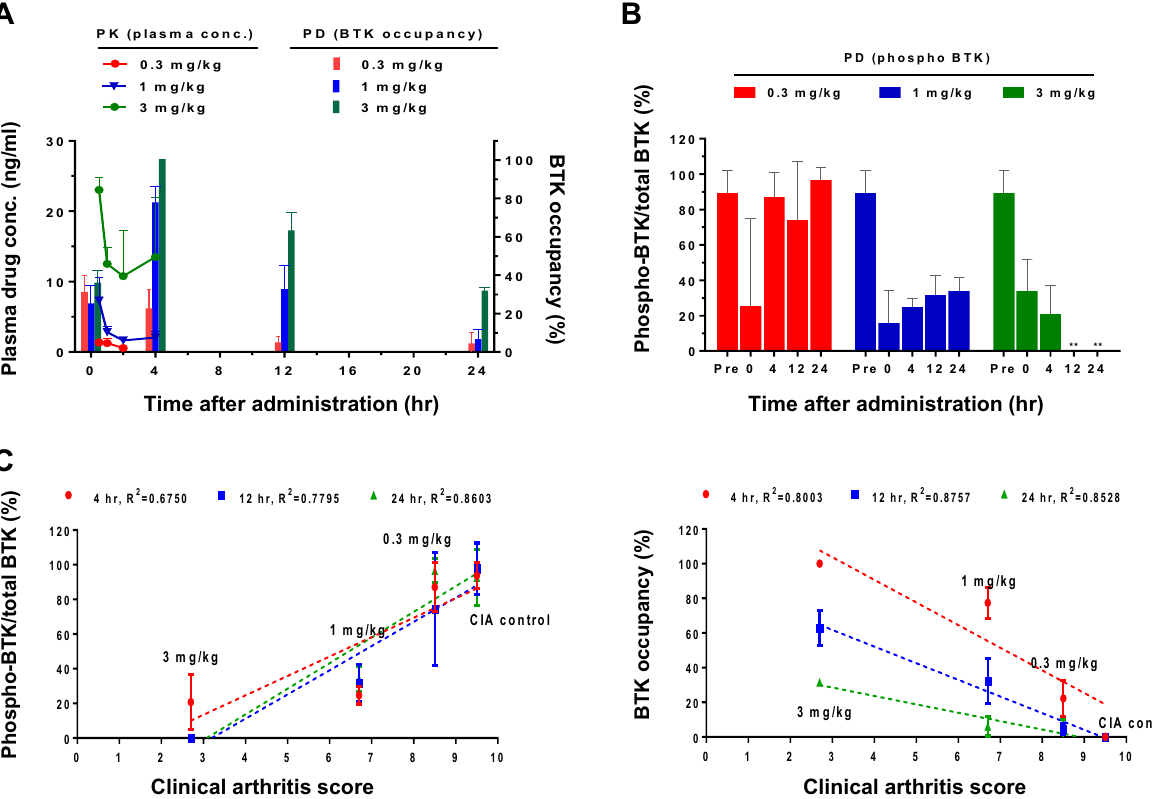
Figure 5. Pharmacologic inhibition of BTK and its correlation with efficacy. ( A , B ) Whole blood was collected from the CIA-induced rats at the 0, 4, 12, 24 h after final drug administration, and then PBMCs and plasma were isolated. BTK phosphorylation was detected by immunoblotting and normalized to the total BTK level, and BTK occupancy was measured by ELISA using a biotinylated probe as described in the Materials and Methods. The concentration of poseltinib in the plasma was below the LLOQ at 4 h after administration. Full-length blots are presented in Supplementary Fig. 1. ( C ) Correlations between drug efficacy (clinical arthritis score) and the